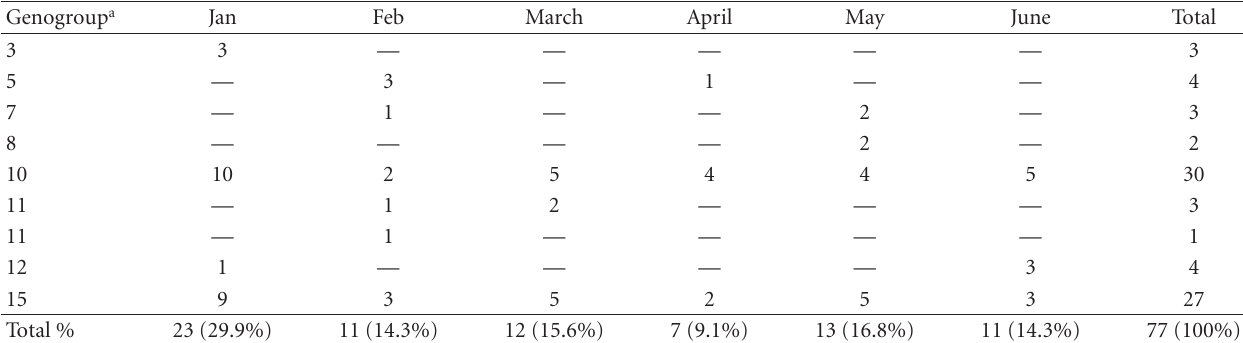
Table 4: Distribution of S. enterica genogroups by month for strains recovered from the Suwannee River. Genogroup a